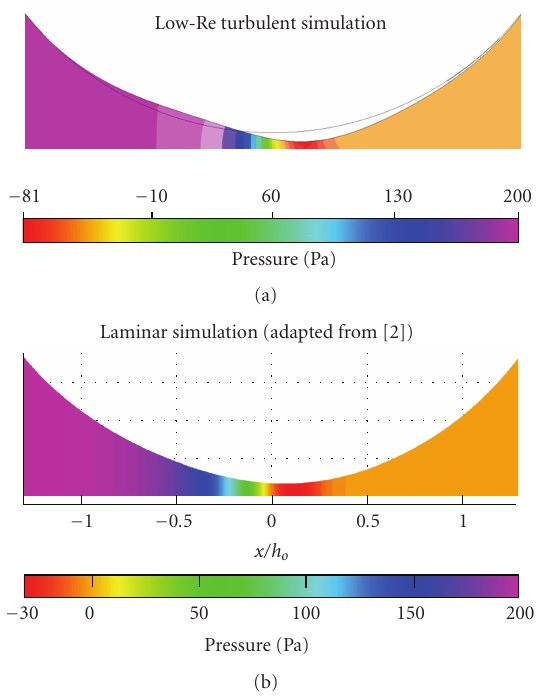
Figure 8: Pressure distribution in the vicinity of the constriction at Δ P = 200Pa for case with initial constriction height = 1.2mm and p e = 200Pa ( P o = 100Pa, ν o = 10m/s and h o = 15mm